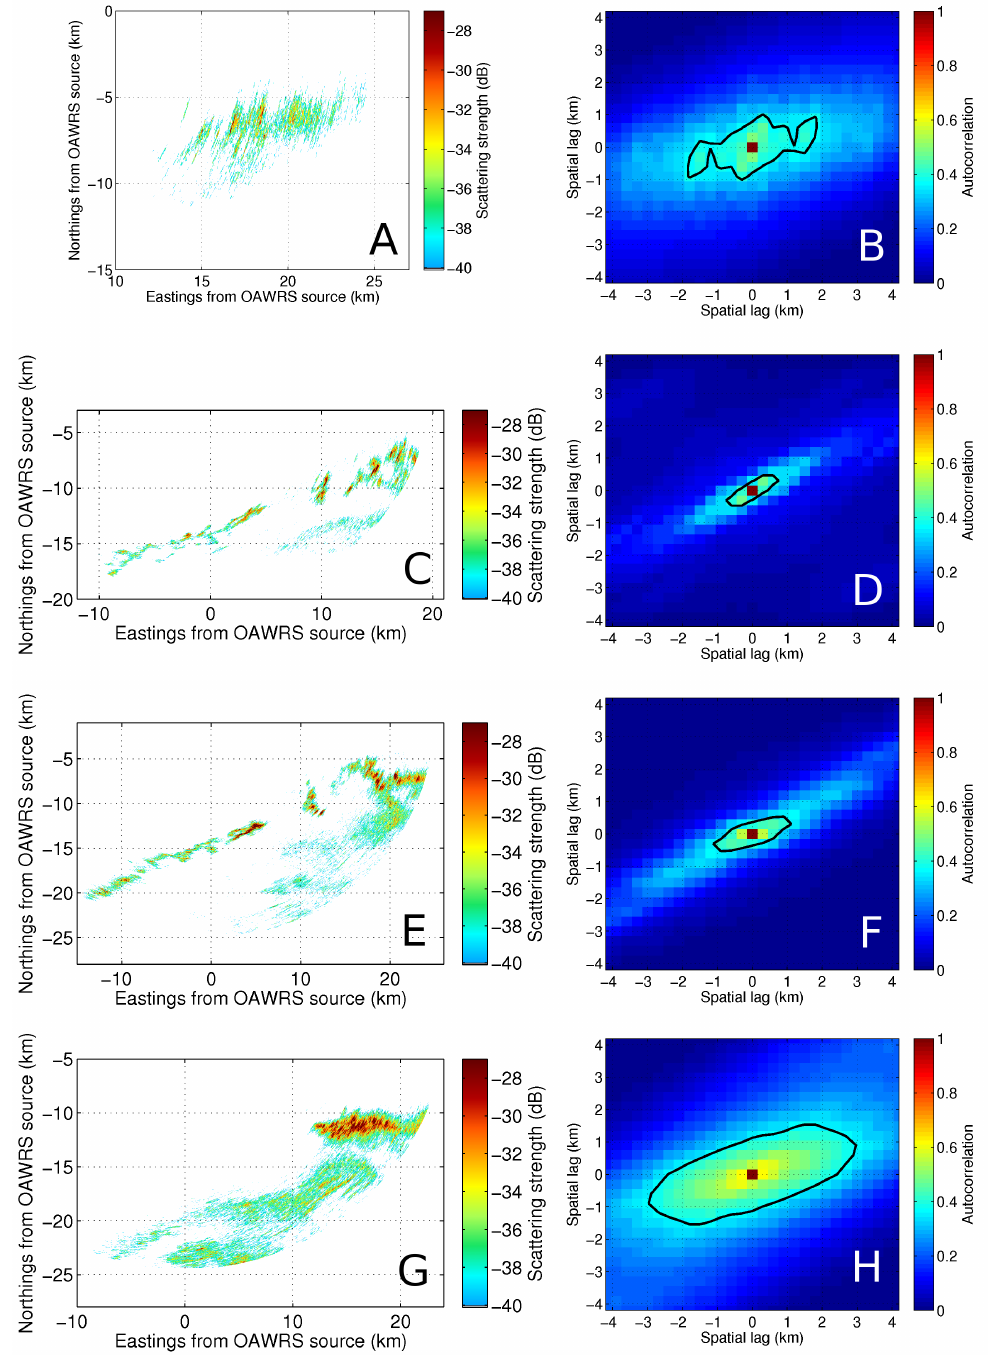
Figure A1. The OAWRS scattering strength images and corresponding exemplary coherence areas taken at ( A , B ) 17:25:00; ( C , D ) 18:42:30; ( E , F ) 19:52:30; ( G , H ) 21:37:30 EDT on 29 September 2006. The e-folding lengths from the peak of the 2D autocorrelation function of herring scattering strength are plotted in